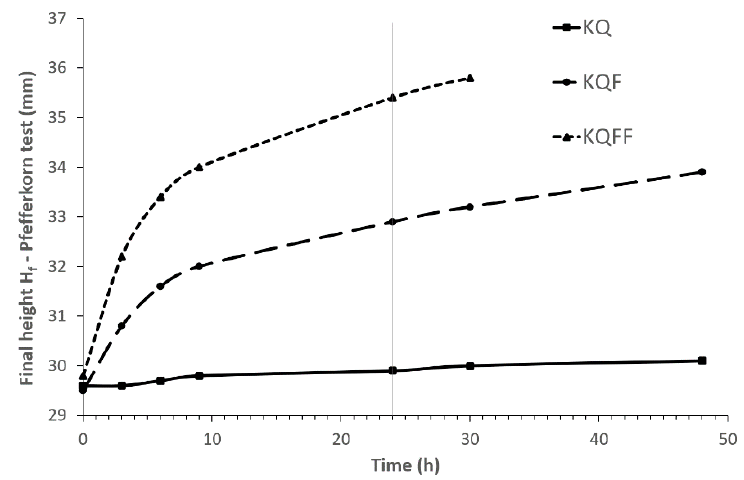
Figure 4. The effect of plastic body ageing on plasticity, according to the Pfefferkorn test—deformed final height H f .